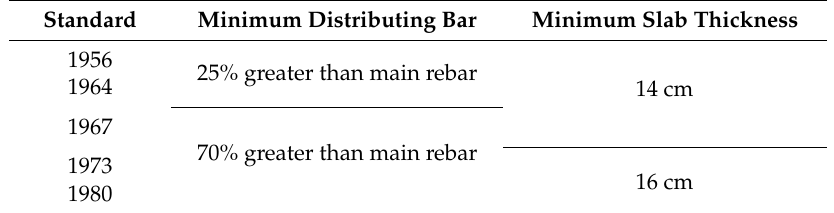
Table 6. Comparison of minimum design distributing bar and slab thickness between different design